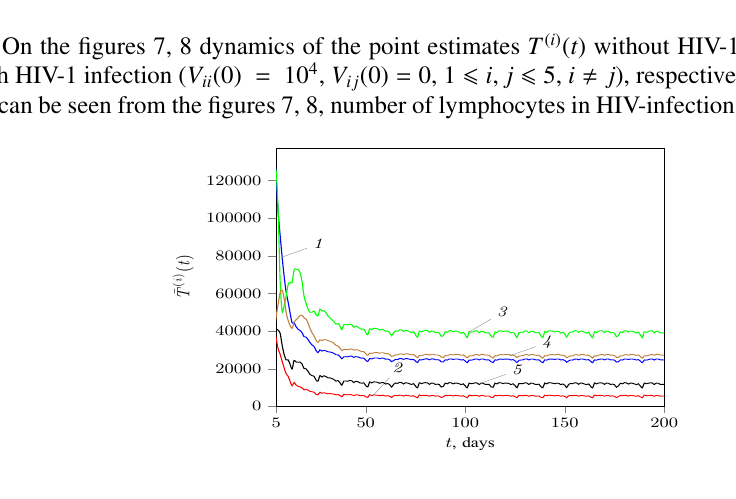
1 Figure 8. Dynamics of point estimates T ( i ) ( t ) with HIV-1 infection at experiment 2.